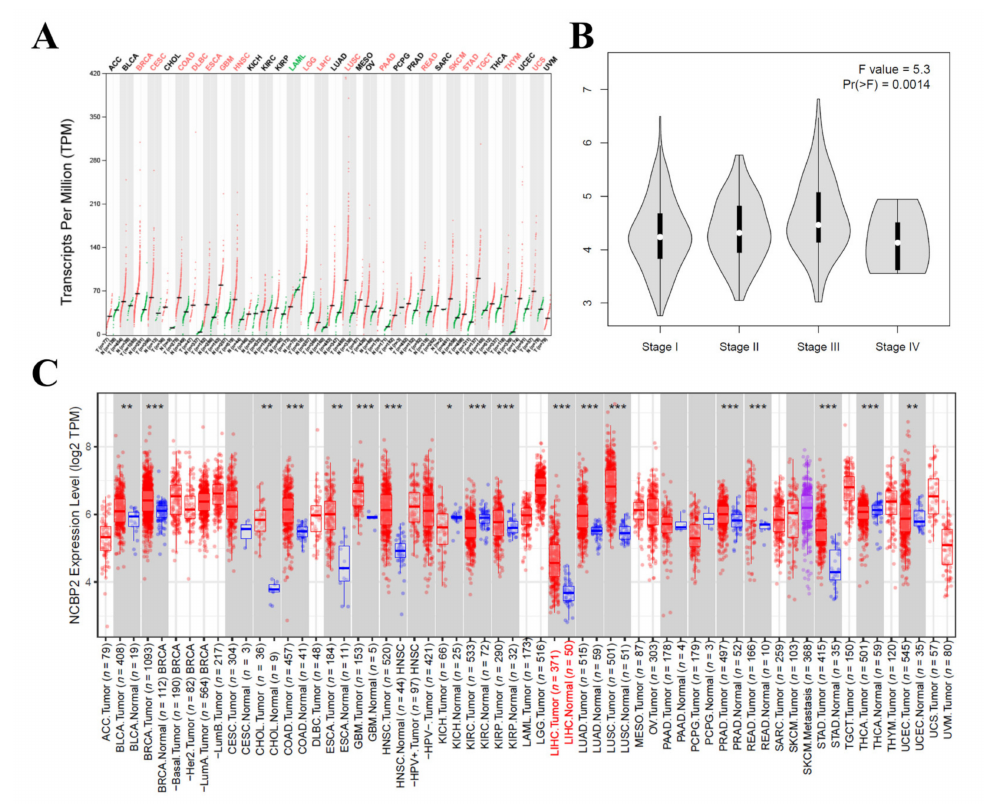
Figure 5. NCBP2 expression levels in HCC. ( A ) Expression patterns of NCBP2 in 33 cancer types and paired non-tumor samples. ( B ) Violin plots reveal relationship between NCBP2 expression and LIHC staging. ( C ) Human NCBP2 expression levels in different tumor types determined by TIMER (* p < 0.05, ** p < 0.01, *** p < 0.001). TIMER: Tumor Immune Estimation